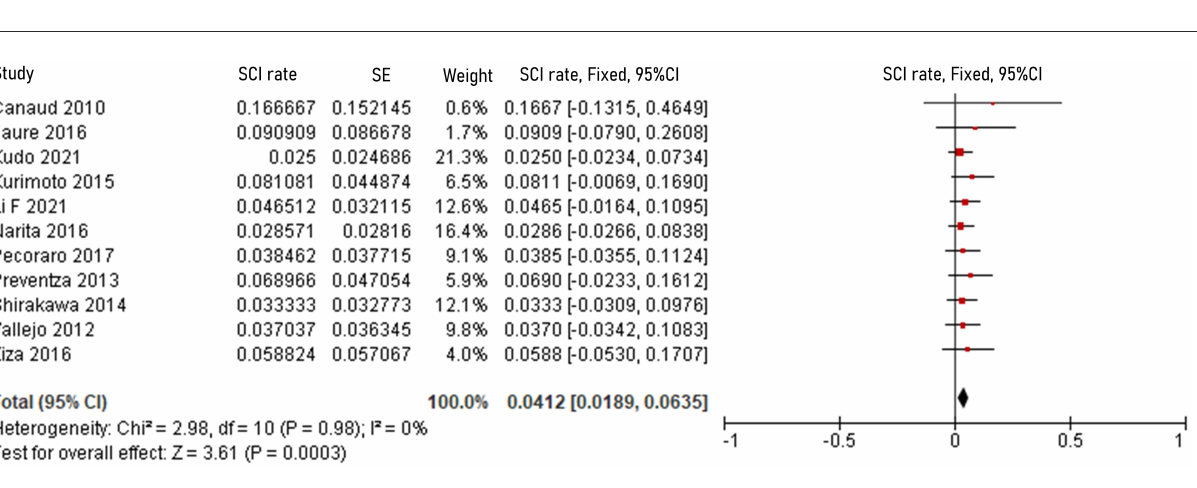
FIGURE7 Forest plot showing the fixed-effects proportion meta-analysis for RTAD rate. CI, confidence interval; SE, standard error; RTAD, retrograde type A